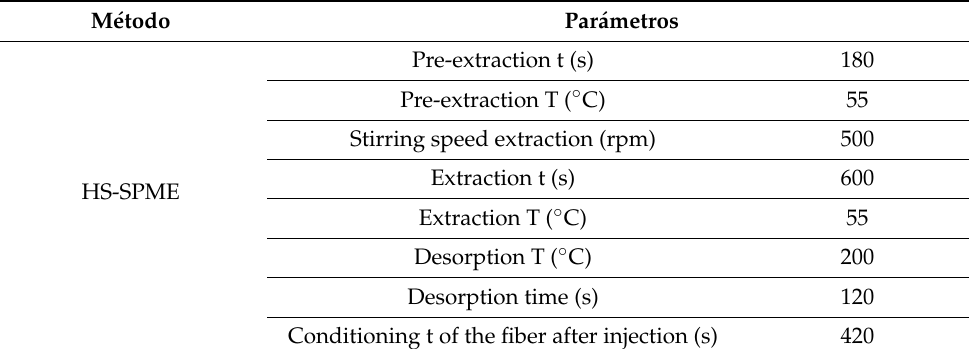
Table 2. HS-SPME optimal